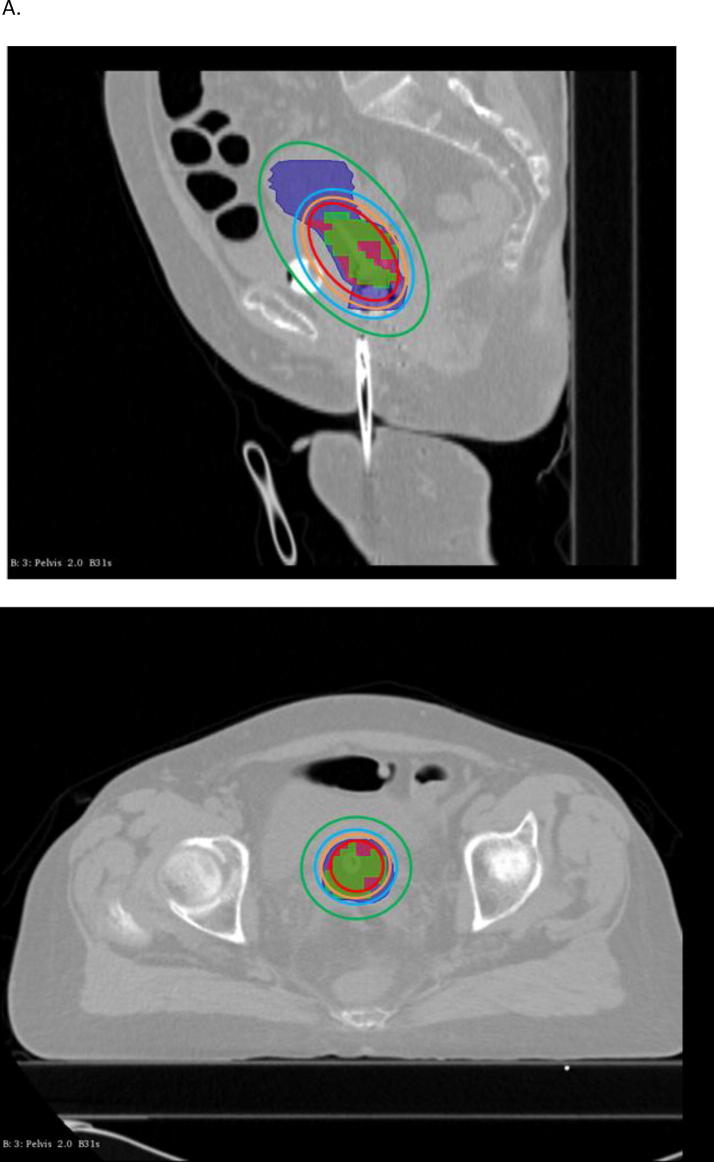
Examples of brachytherapy planning in 2 different patients who experienced distant relapse. In these 2 cases, the entire V1 (green) was not included in the CTV-HR (magenta volume) and not covered by the D2eq = 85 Gy (red), neither by the 80 Gy isodose (orange). It was however included in the CTV IR (blue volume) and covered by the 78 Gy (cyan) and 65 Gy isodoses (green). (For interpretation of the references to colour in this figure legend, the reader is referred to the web version of this article.)